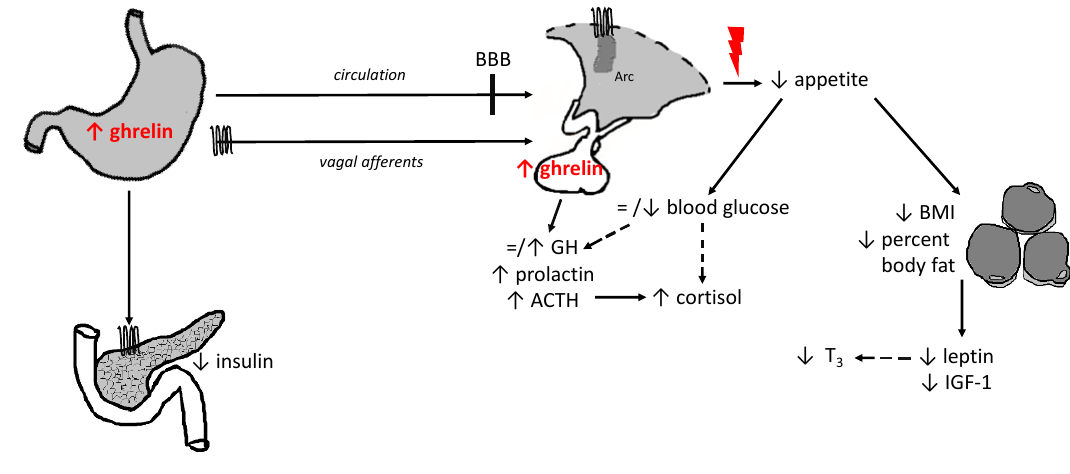
Figure 1. Hypothesized alterations of ghrelin’s signaling in anorexia nervosa. growth hormone